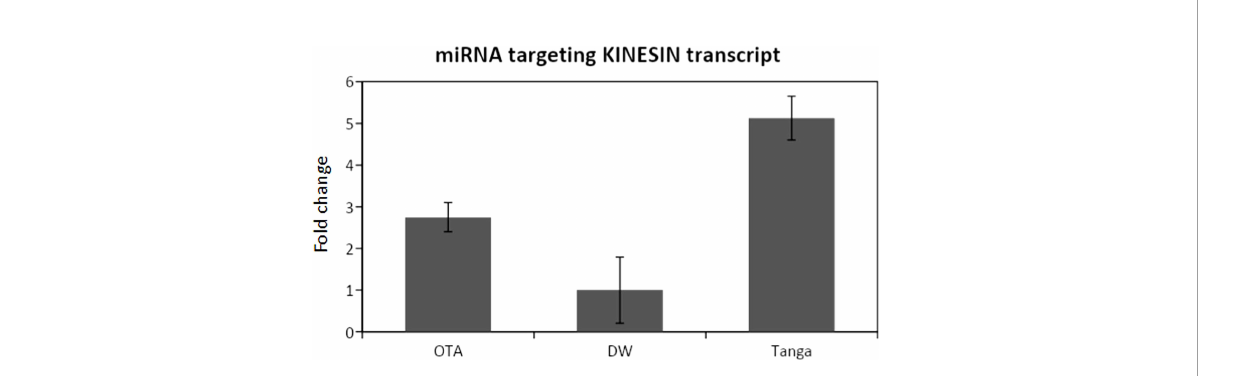
FIGURE 4 qPCR analysis for the miRNA that targets the Kinesin transcript. DW: Don Walter. Tanga: Tanganyika. The miRNA is overexpressed in the apomictic cultivar Tanganyika (p<0.05). Data was normalized with respect to the genotype that showed the lower